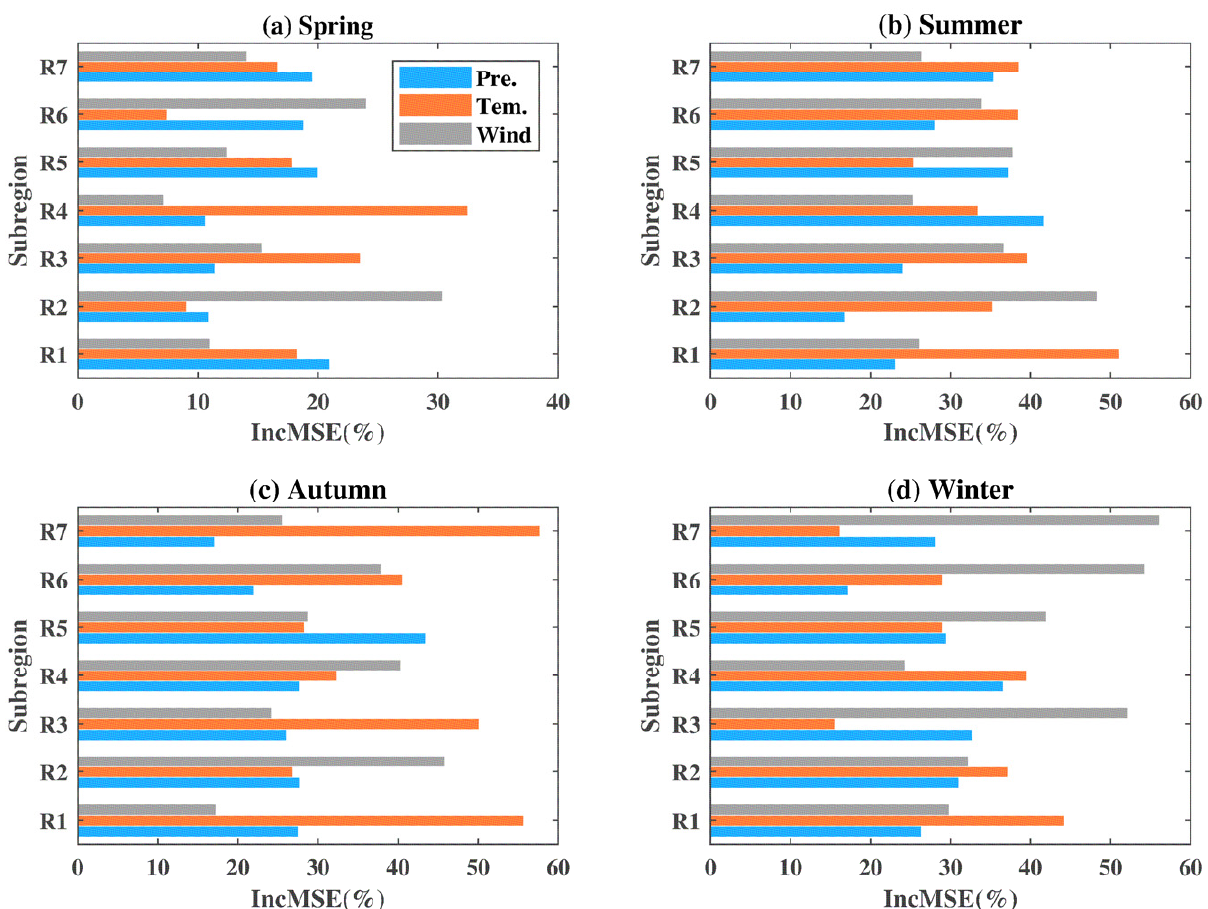
Figure 17. Contributions of the three climatic factors to seasonal BA in R1 − R7: ( a ) spring; ( b ) summer; ( c ) autumn and ( d ) winter.